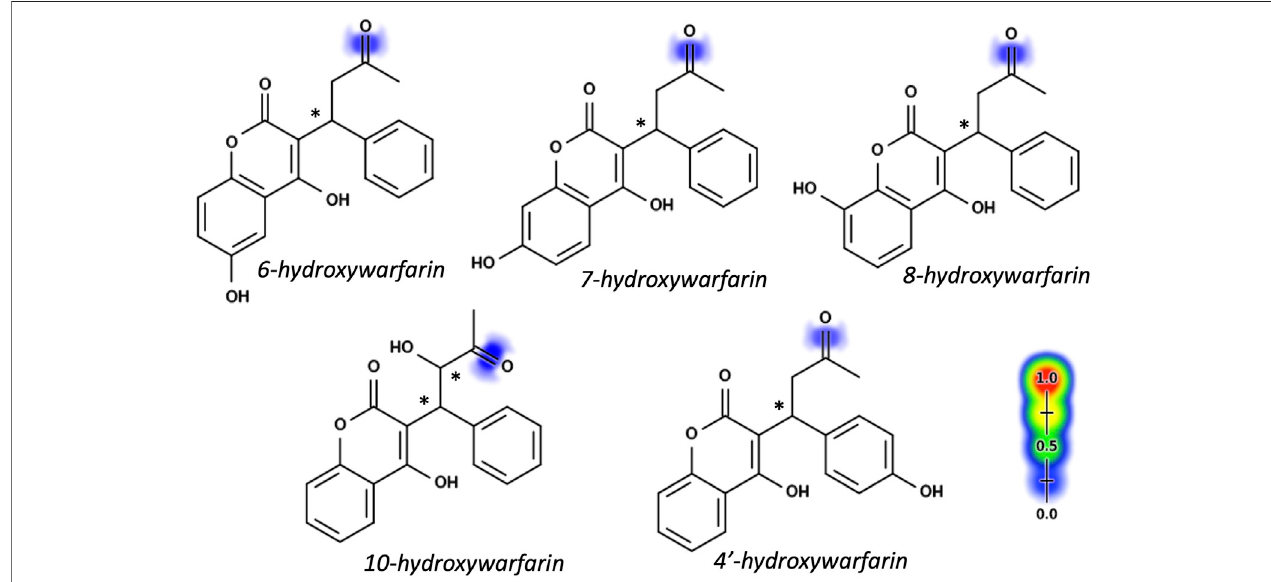
FIGURE2| Hydroxywarfarinalcoholswithreductionmodelpredictions.ReductionpredictionsforhydroxywarfarinsweremadeusingtheXenositeRainbowModel (Dang, et al., 2020). Individual bonds are scored from 0 to 1 with higher scores indicating higher likelihood of reduction and indicated pictorially with color shading from bluetored.ScoresforreductionattheC11positiontoformhydroxywarfarinalcoholsareshownin Table1 .Asterisksdenotechiralcenters.Allhydroxywarfarinscontain a chiral center at C9 except for 10-hydroxywarfarin, which contains another at position 10.